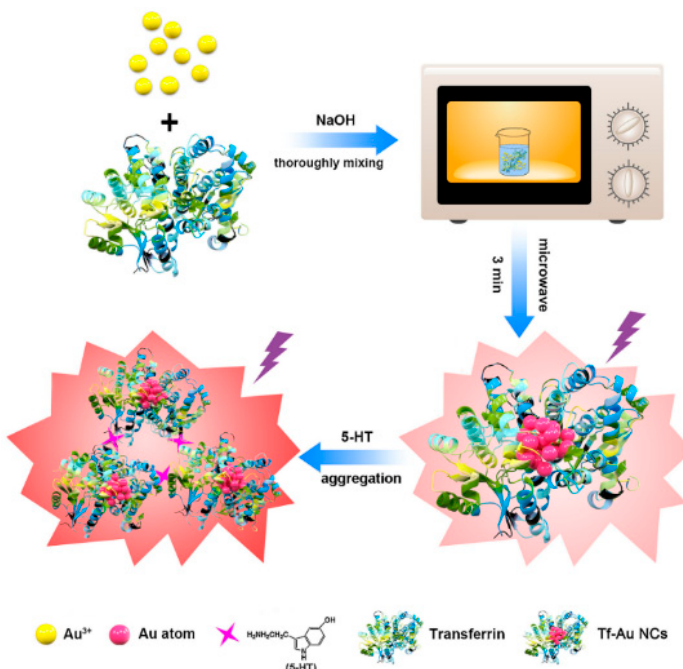
Figure 1. Diagram of the synthesis and detection application of transferrin-AuNCs for fluorescent detection of 5-HT. Reprinted with permission [32]. Copyright 2019 Elsevier B.V.